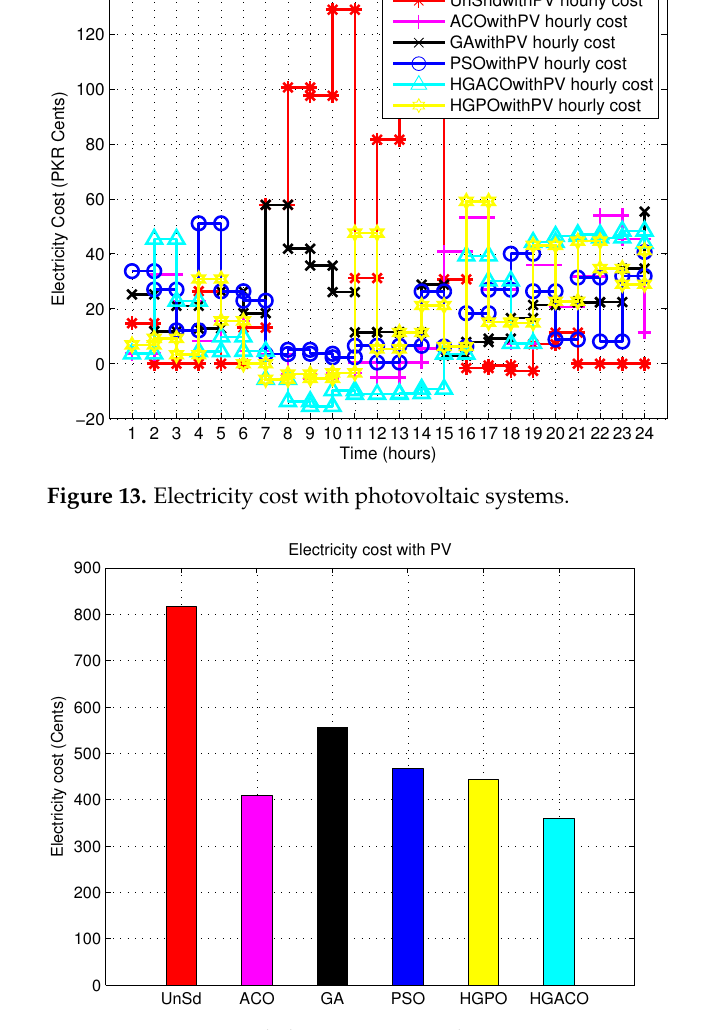
Figure 14. Aggregated electricity cost with PV. Table 9. Scenario II: electricity cost assessment with